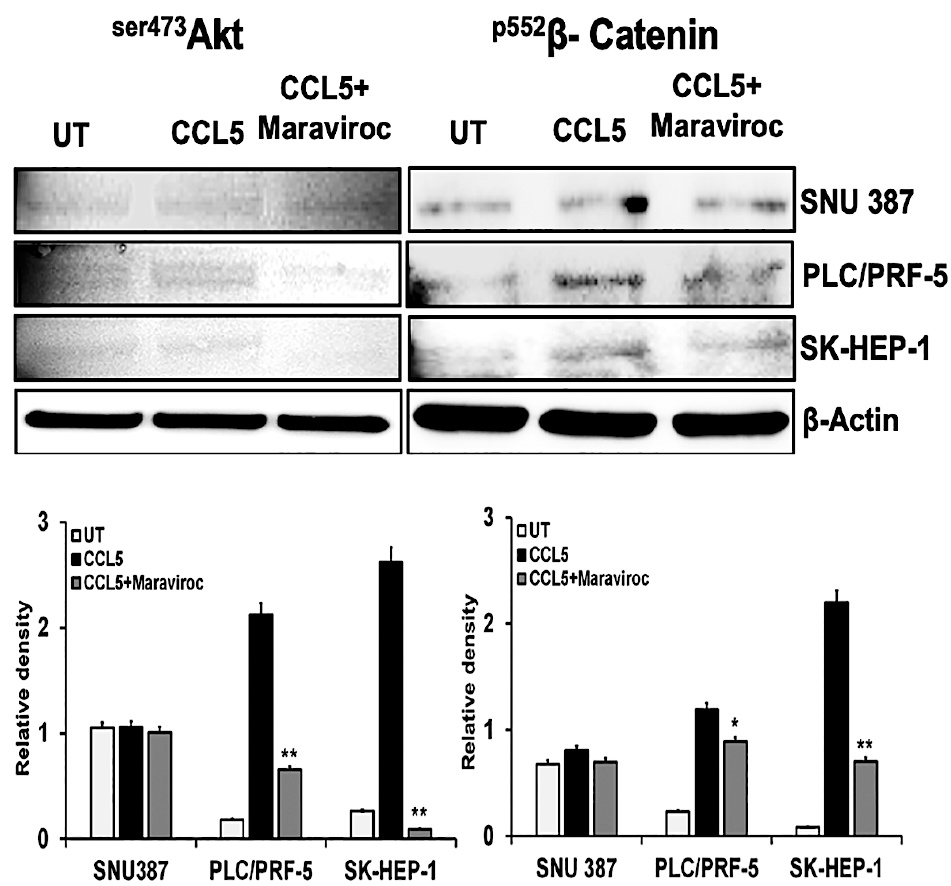
Figure 5. The CCL5 / CCR5 interaction mediates cell survival and the epithelial to mesenchymal transition (EMT) of HCC cells. HCC cells were treated with CCL5 with or without maraviroc for 30 min, and an expression of the cell survival marker ( Ser473 Akt) and a marker for the EMT ( P552 β -catenin) were analyzed by immunoblots. β -Actin was used as a loading control. The immunoblots shown are representative of three independent experiments. Densitometric assessments of the proteins are shown in the lower panel. Data, presented as means ( ± standard error), were analyzed by Student’s t -test. ** and * indicate p values ≤ 0.01 and 0.05, respectively.